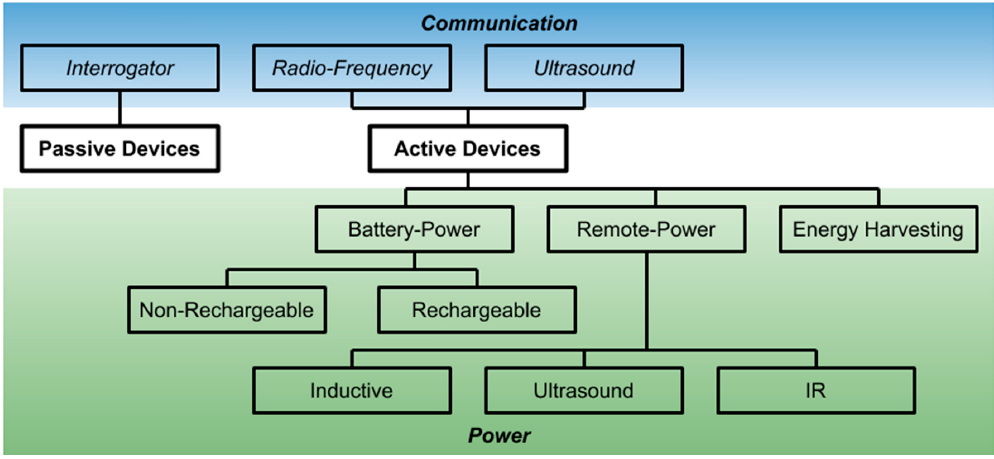
Figure 1. Communication and power schemes typically used in active and passive sensors.